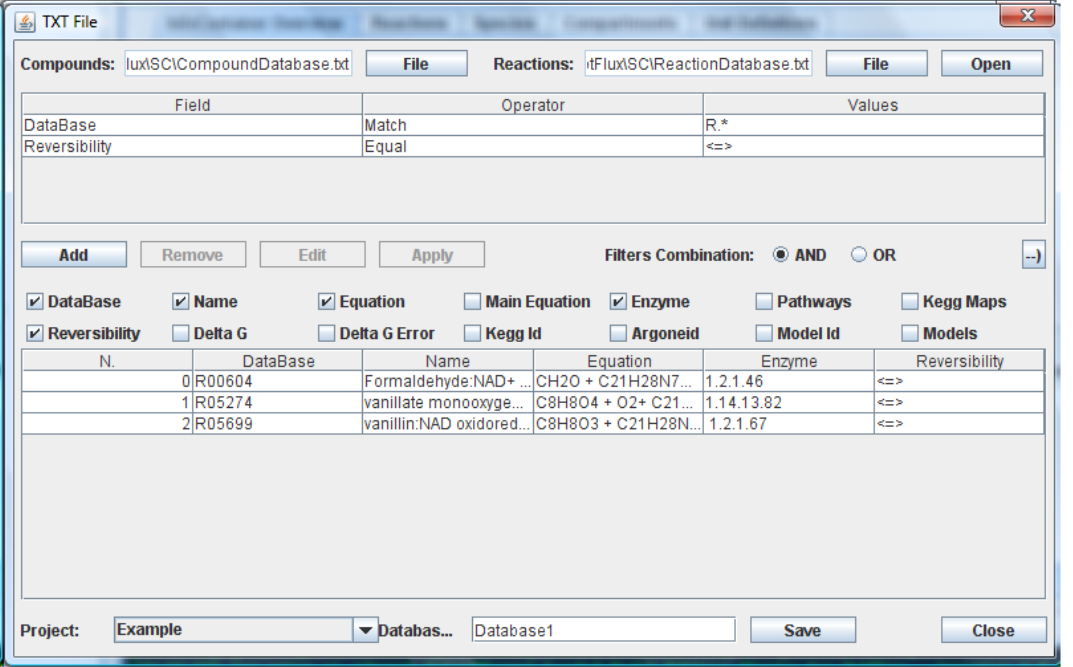
Figure 2: Interface for selecting reactions and importing them to OptFlux. In this example, the user chooses only the reactions where ids start with “R” and that are